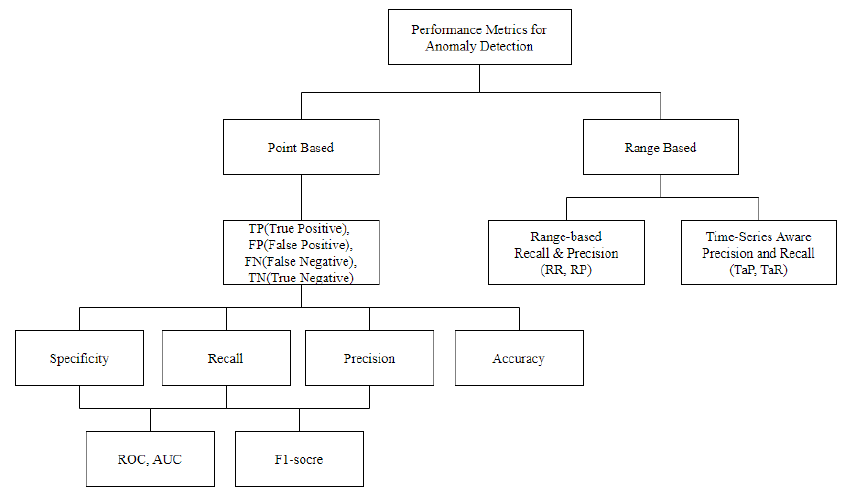
Figure 2. Performance metric tree for anomaly detection evaluation.